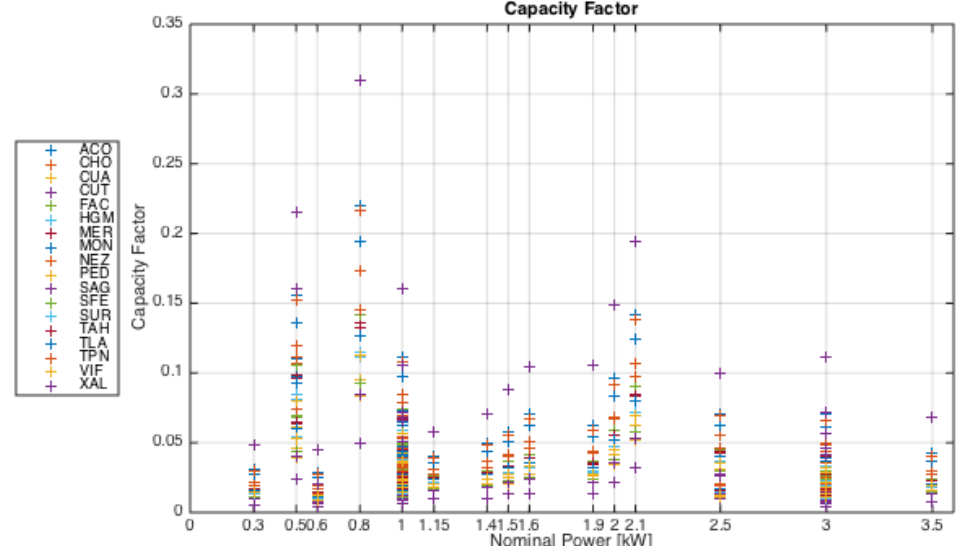
Figure 14. In order to observe general capacity factor tendencies, SWTs with equal nominal powers are grouped and plotted. The turbine with a nominal power of 0.8 kW presents higher CF values that range from 5 to 35%, and this is also the model with a positive calculated ANPV .